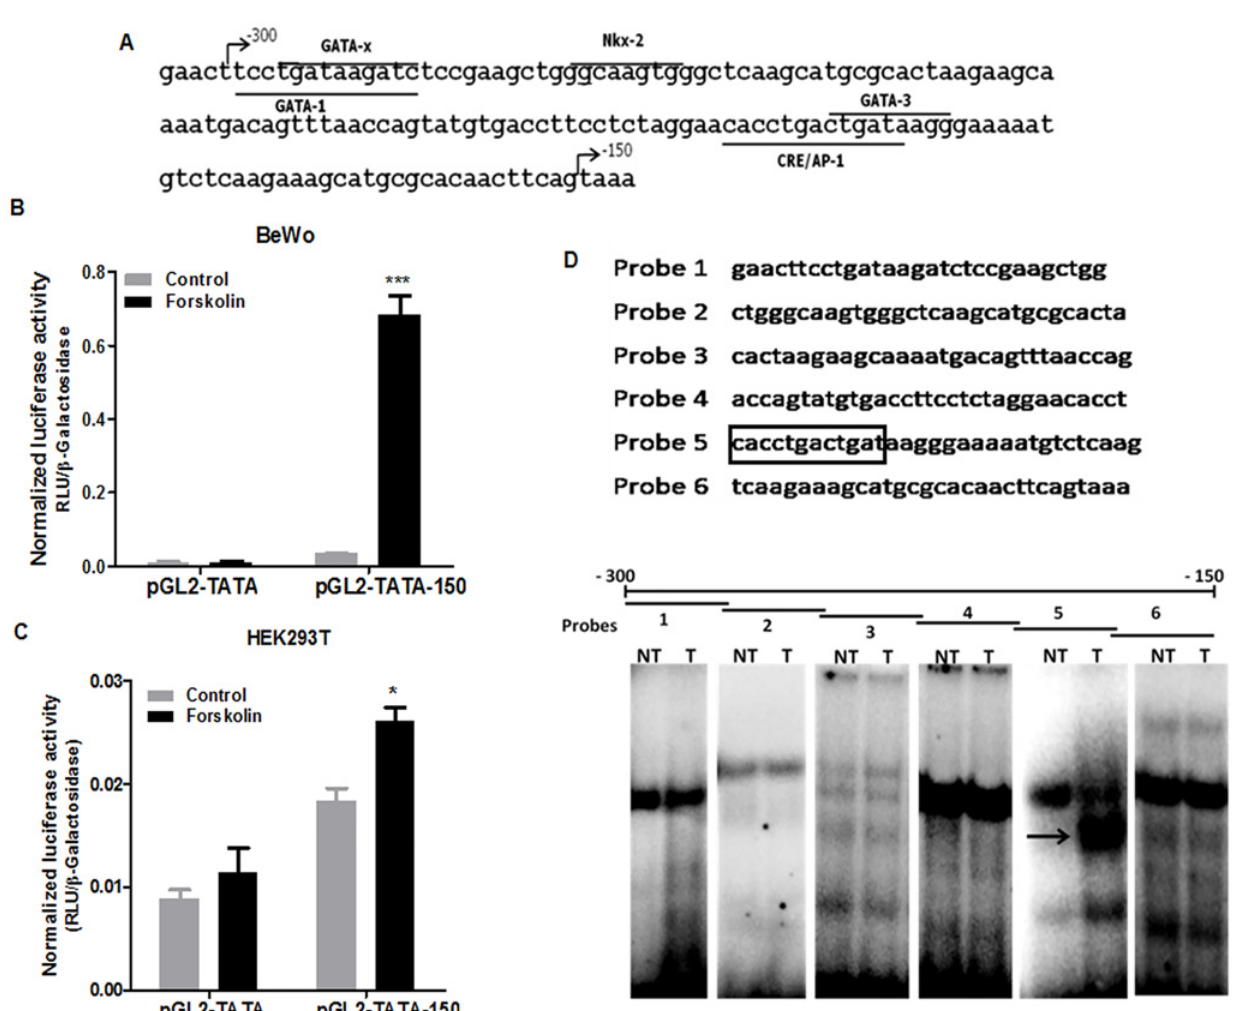
Fig 2. Analysis of the-300 to-150 Syncytin-2 region responsive to forskolin. (A) Sequence of the-300 to-150 promoter region of Syncytin-2 in which putative transcription binding sites are underlined. (B-C) The pGL2-TATA-150 vector comprising the-300 to-150 Syncytin-2 promoter region and a TATA box upstream of the luciferase reporter gene (vs. the pGL2-TATA control vector) (400 ng) was co-transfected along with 200 ng of pRcActin-LacZ in BeWo (B) or 293T cells (C) . After transfection, cells were either left untreated (Control) or treated with 50 μ M of forskolin for 12 h. Cells were harvested and analyzed for relative luciferase expression. Luciferase activity values were normalized for β -galactosidase activity and are expressed as the mean normalized RLU ± S.E.M. from three independently transfected cells in the same experiment. These results are representative of three independent experiments ( * p < 0.05; *** p < 0.001). (D) Five different probes covering the-300 to-150 region were used for EMSA. Nuclear extracts (10 μ g) from non-treated (NT) or treated (T) BeWo cells were incubated with the different labeled probes covering this 150 nt region. The arrow points to a specific signal observed with probe